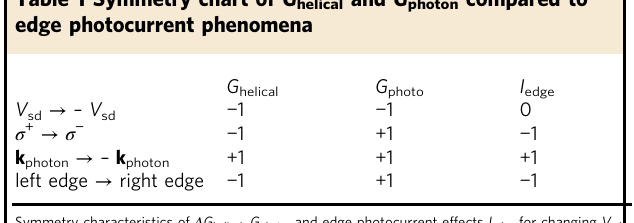
sign conservation. The value 0 denotes that I edge is independent from j and the